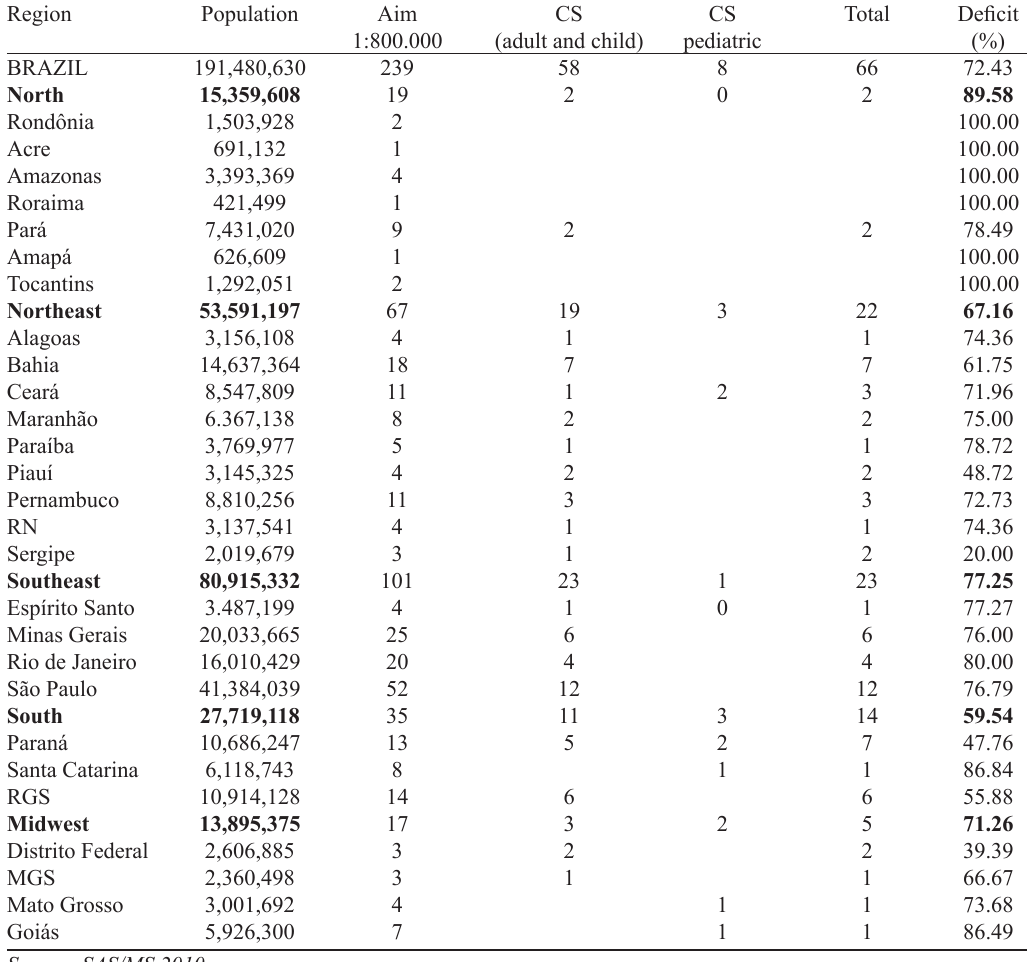
Table 2. Distribution of Units (HU) in pediatric cardiovascular surgery (CS) in regions and states of the Federation in 2009